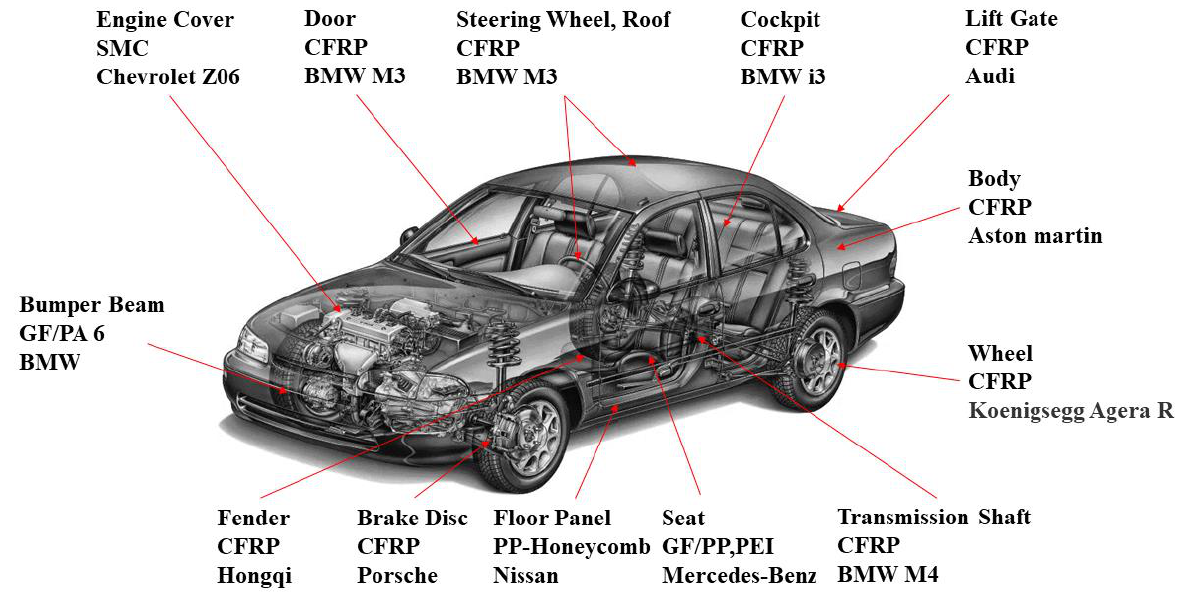
Figure 1. Application of composites in vehicle.